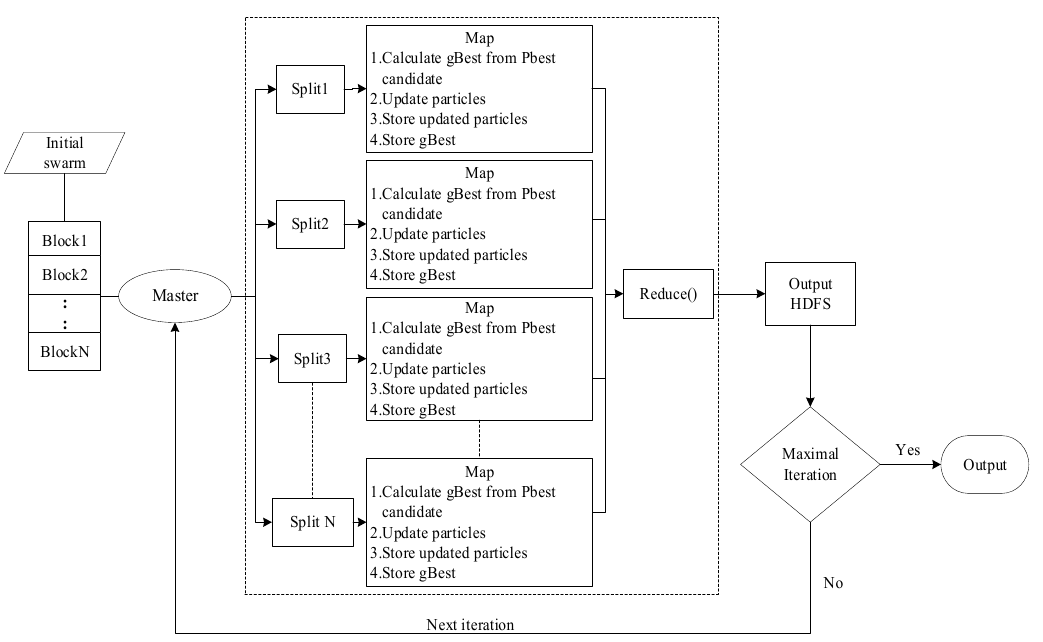
Figure 4. Iterative flow chart of the MR-PSO algorithm.